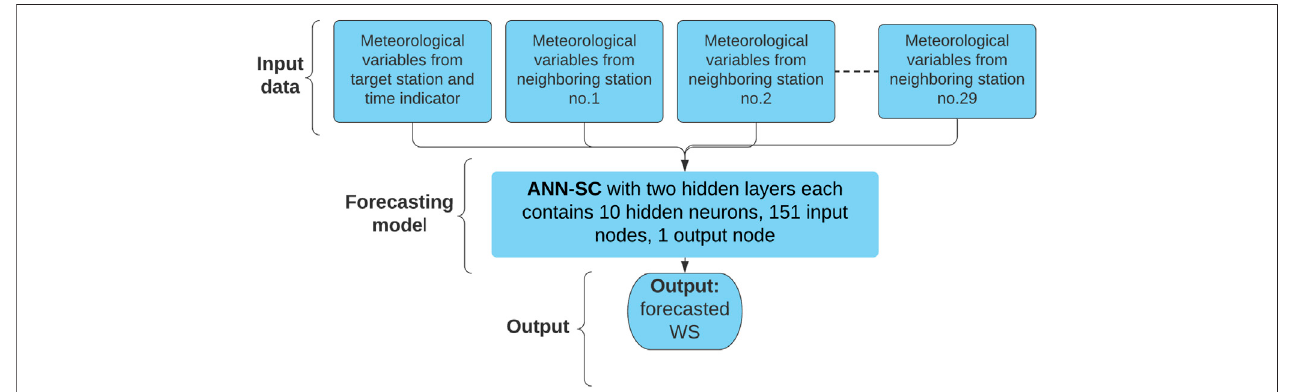
FIGURE 3 | Structure of the ANN-SC with the input features from 1 target station and 29 neighboring stations.